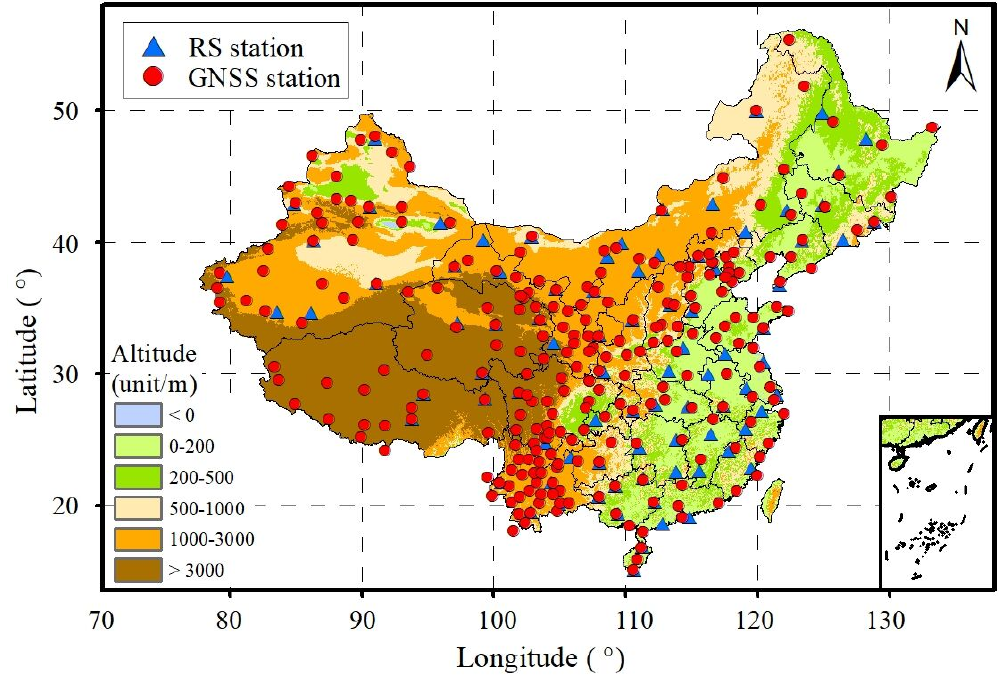
Figure 2. Geographic distributions of GNSS and RS stations selected in China.